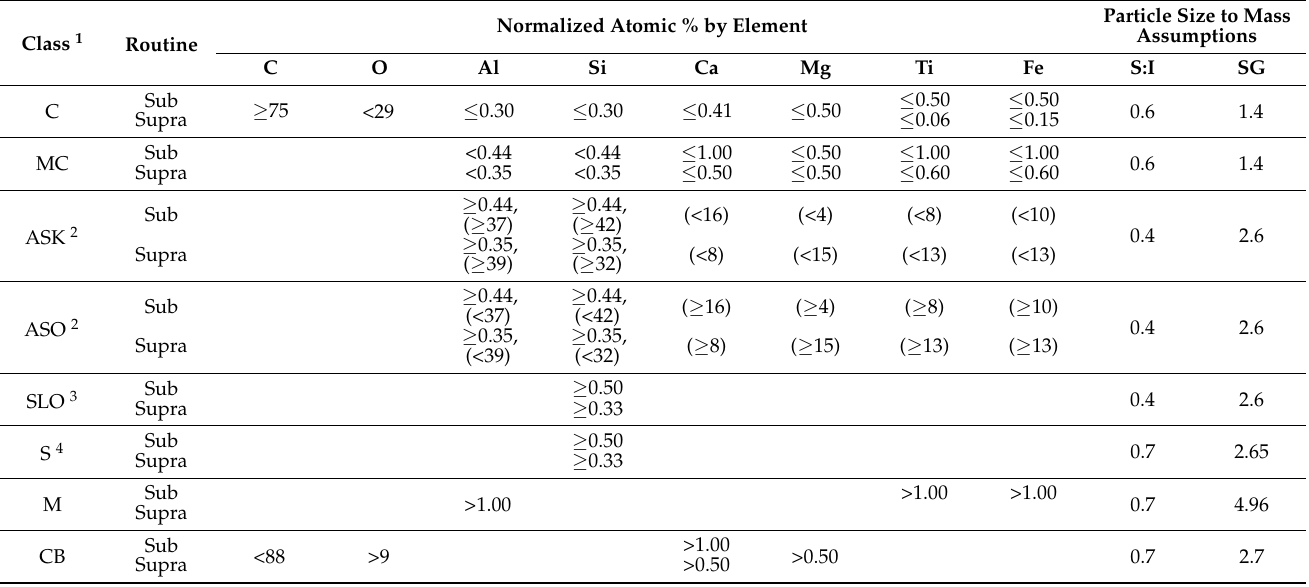
Table 3. SEM-EDX classification criteria for sub- and supra-micron particles, along with assumptions for S:I ratio and SG for each mineralogy class (updated from Sarver et al.